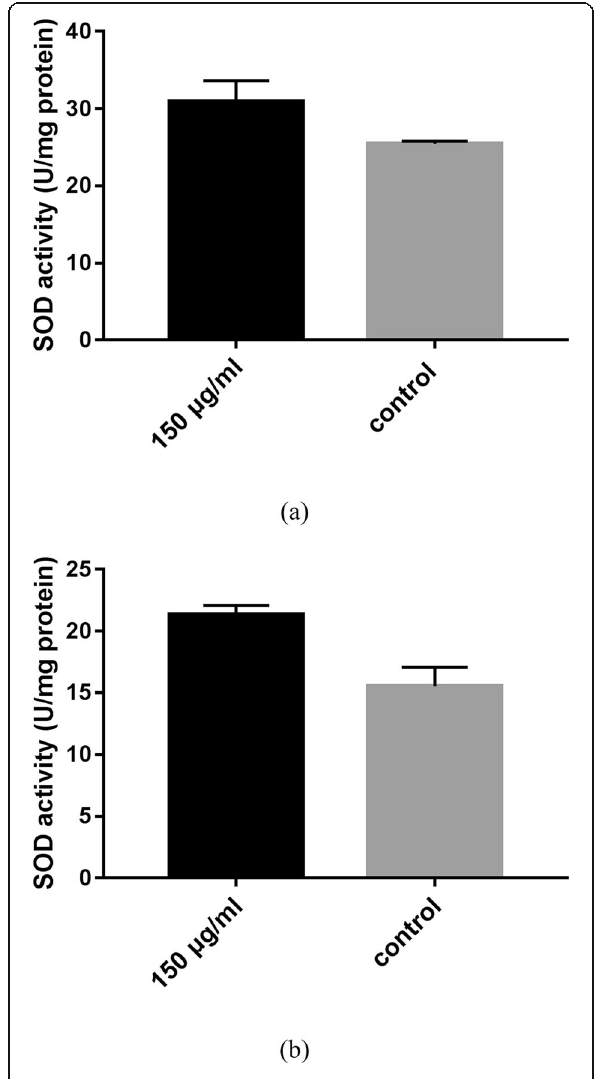
Fig. 3 Effect of JPYW on SOD activity in C. elegans N2 worms. a SOD activity in C. elegans N2 worms. Quantitative comparisons showed that SOD levels were significantly higher in JPYW-pretreated worms than in control worms (25.44 ± 0.22 vs. 30.96 ± 1.53 U/mg of protein, P < 0.05). b SOD activity in aged C. elegans N2 worms. Quantitative comparisons showed that SOD levels were significantly higher in JPYW-pretreated aged worms than in control worms (15.54 ± 1.09 vs. 21.35 ± 0.52 U/mg of protein, P <